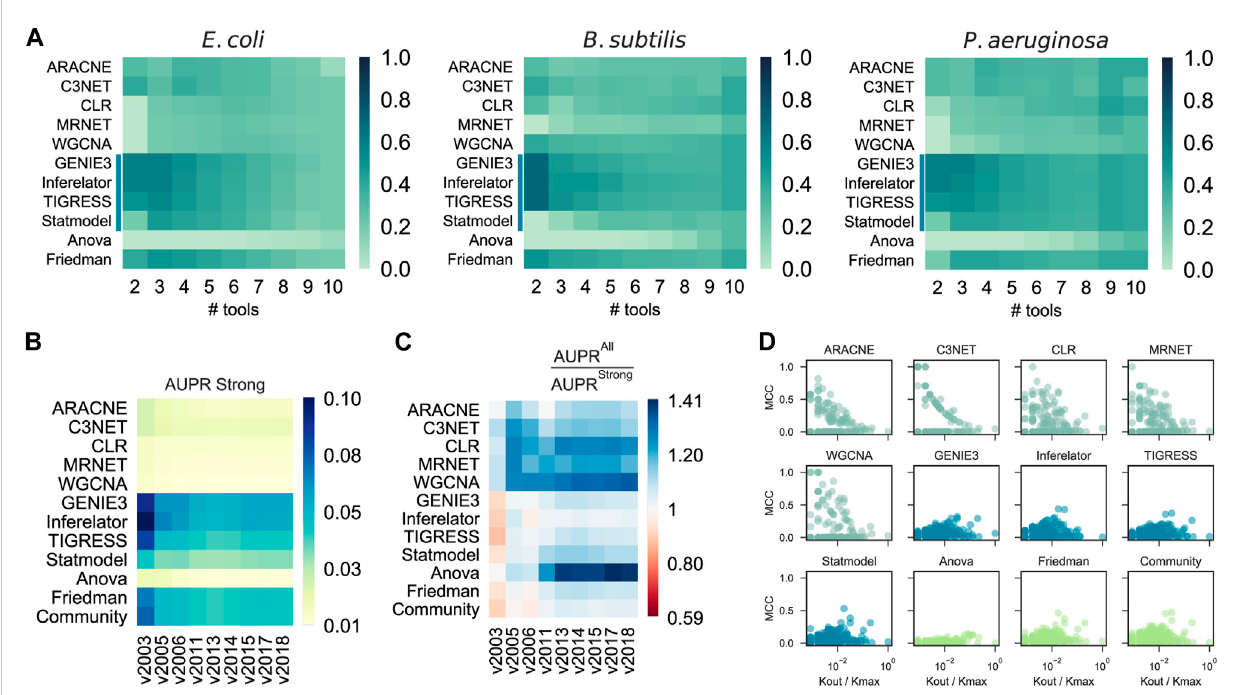
FIGURE 4 Effects of results integration, GS incompleteness, and Regulon-level assessment. (A) Probability of a tool to outperform Community by its integration with others (# tools) into a selective community. CAUS tools are affected rather than improved by others. (B) Assessment of GRN inference methods with thehistorical reconstruction ofthe E. coli GRN. The incompletenessof theGRN used as GSdoes not affect theAUPR score. (C) AUPR ratio between a “ strong ” GS and a “ weak ” one. In most cases, the tools performed better when a “ weak ” GS was used. The “ weak ” GS is a superset of the “ strong ” GS including interactions supported by non-directed experiments. (D) Regulon prediction assessment with Matthew ’ s correlation coef fi cient (MCC). Each dot represents a regulon inference for an E. coli TF, higher is better. Out-degree connectivity (Kout) for the TF controlling the regulon is normalized by the maximum connectivity (Kmax) of the E. coli